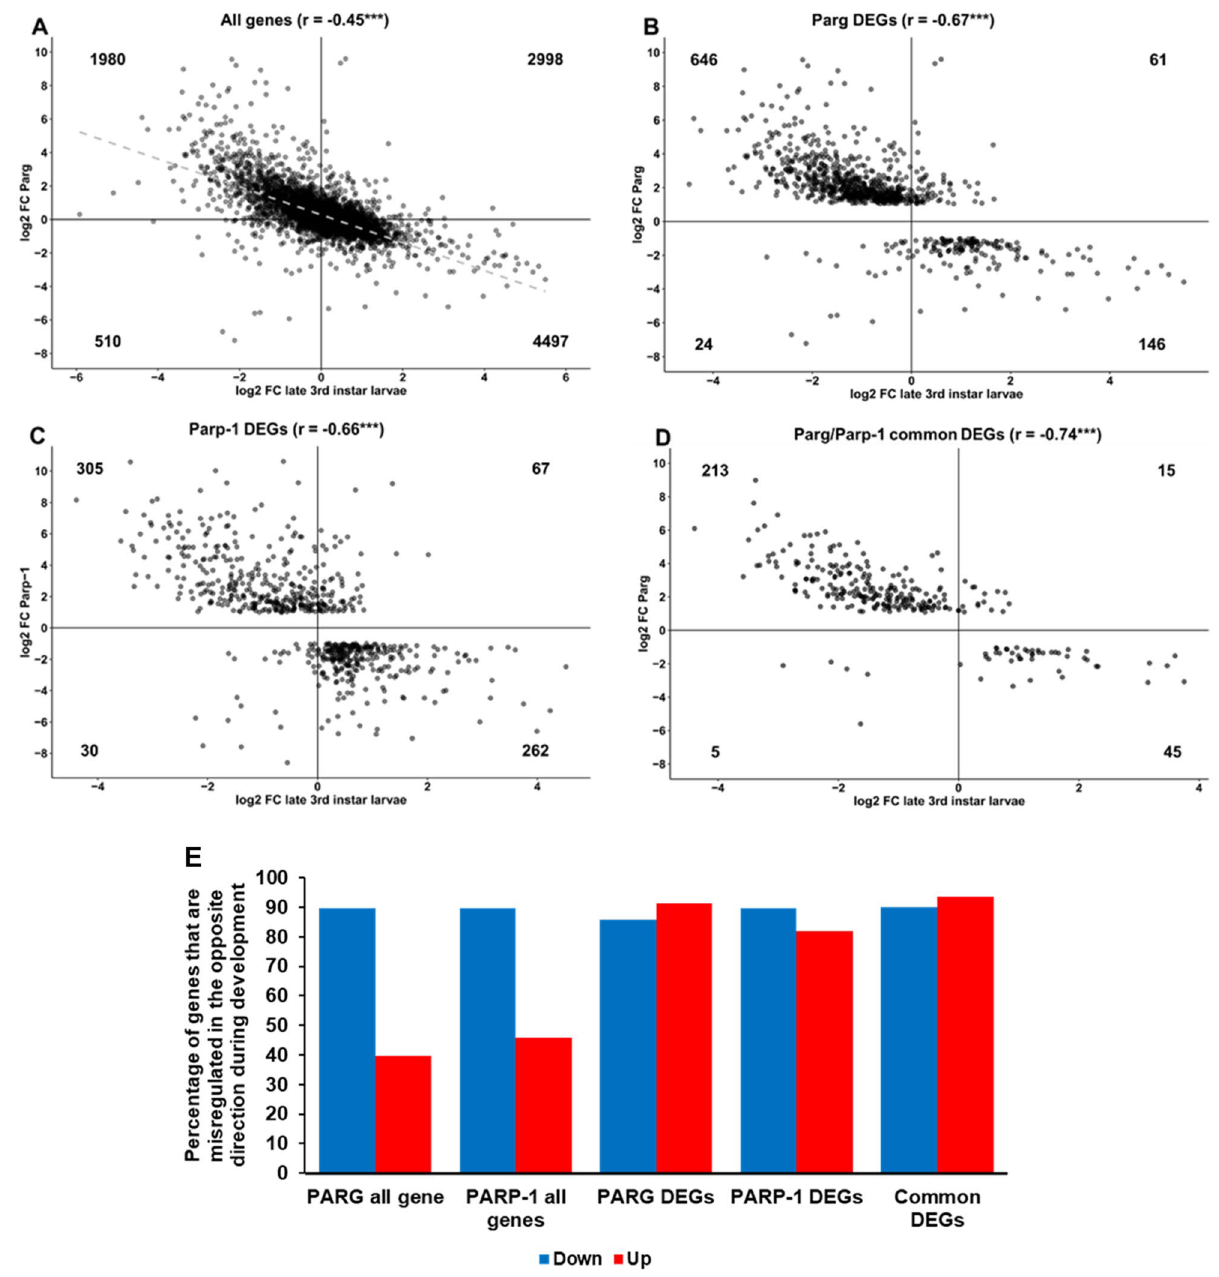
Figure 4. The absence of PARP-1 or PARG affects the expression of developmental genes. ( A - D ) Scatter plots representing the expression of ( A ) 9 985 genes expressed in Parg mutant and during L3 larva puff stage 3–6 and 7–9, ( B ) 877 PARG DEGs expressed in Parg mutant and during L3 larva puff stage 3–6 and 7–9, ( C ) 664 PARP-1 DEGs expressed in Parg mutant and during L3 larva puff stage 3–6 and 7–9, and ( D ) 278 PARP-1/ PARG common DEGs expressed in Parg mutant and during L3 larva puff stage 3–6 and 7–9. X-axis shows a log2 scale of the Fold Change (FC) between L3 larva puff stage 3–7 and 7–9, while Y-axis shows a log2 scale of the FC in the absence of PARG compared to control for ( A , B and D ), or in the absence of PARP-1 for ( C ). The number present in each quadrant corresponds to the number of genes present in this quadrant. The r number is the Pearson correlation coefficient. The p-value is calculated based on the Pearson correlation coefficient and the t-distribution with n-2 degrees of freedom. *** p < 0.01. ( E ) Summary of the data represented in A – D . Genes downregulated in mutants and upregulated during L3 larva puff stage 7–9 are represented in blue, while genes upregulated in mutants and downregulated during L3 larva puff stage 7–9 are represented in red. This graph is a comparison between X- and Y-axis presented in A – D . For example, the red bar in the “All genes” category means that 39.8% of the genes upregulated in the Parg mutant should be downregulated during L3 larva puff stage